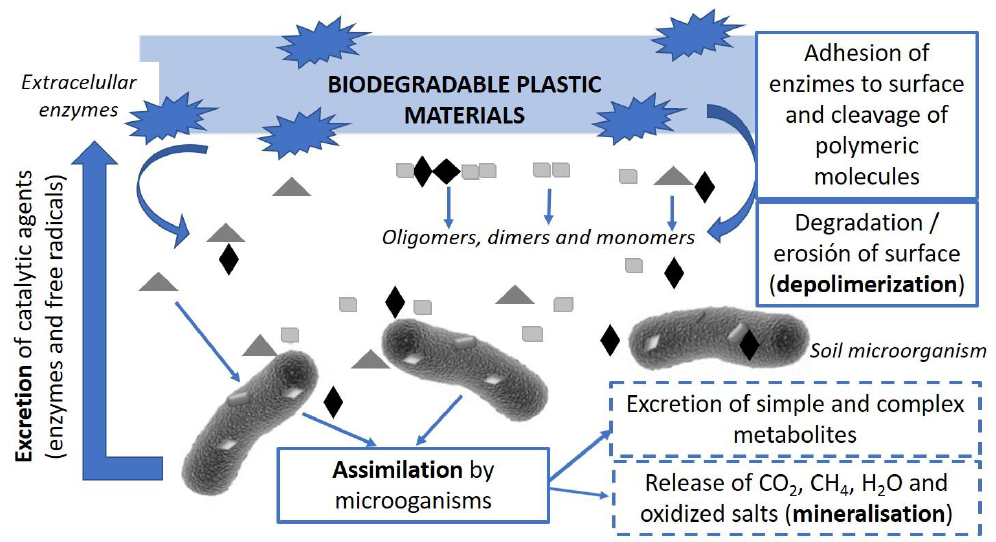
Figure 2 . Polymer biodegradation pathway (Adapted from Youssef & El Sayed [67] and Lucas et al. [65]).